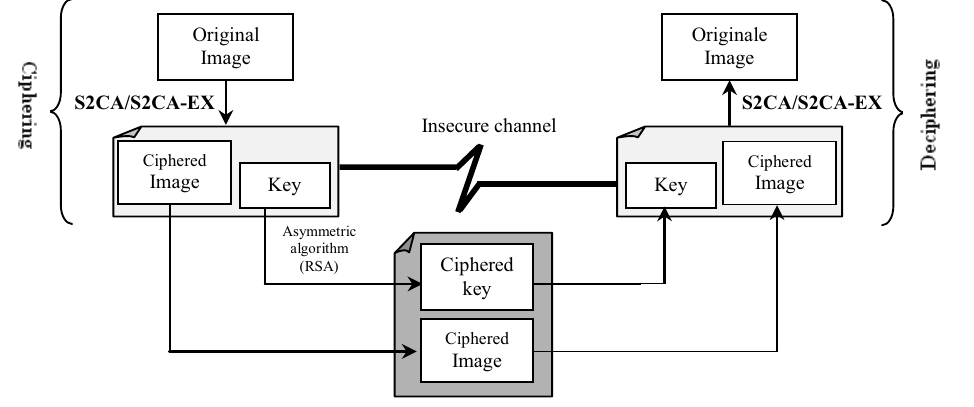
Fig. 15. Hybrid scheme for secure transmission .